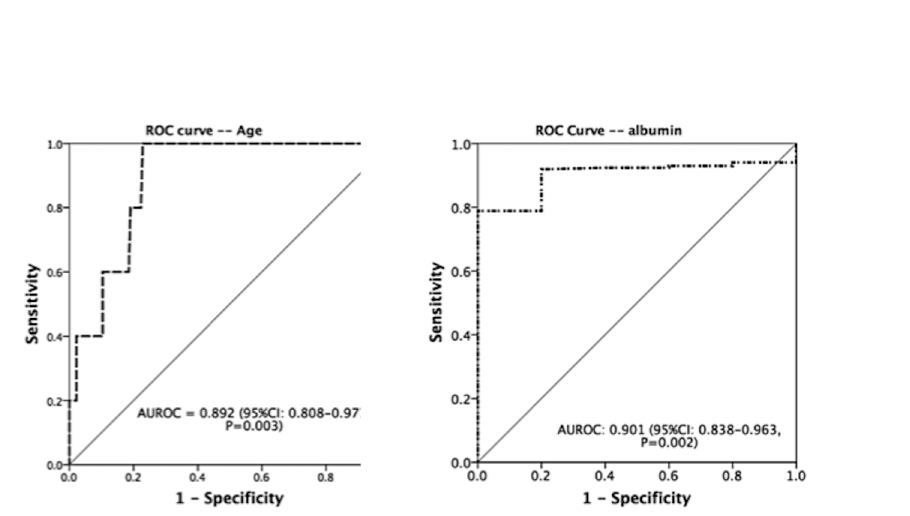
Fig 4. ROC curve for age and albumin in predicting hepatic